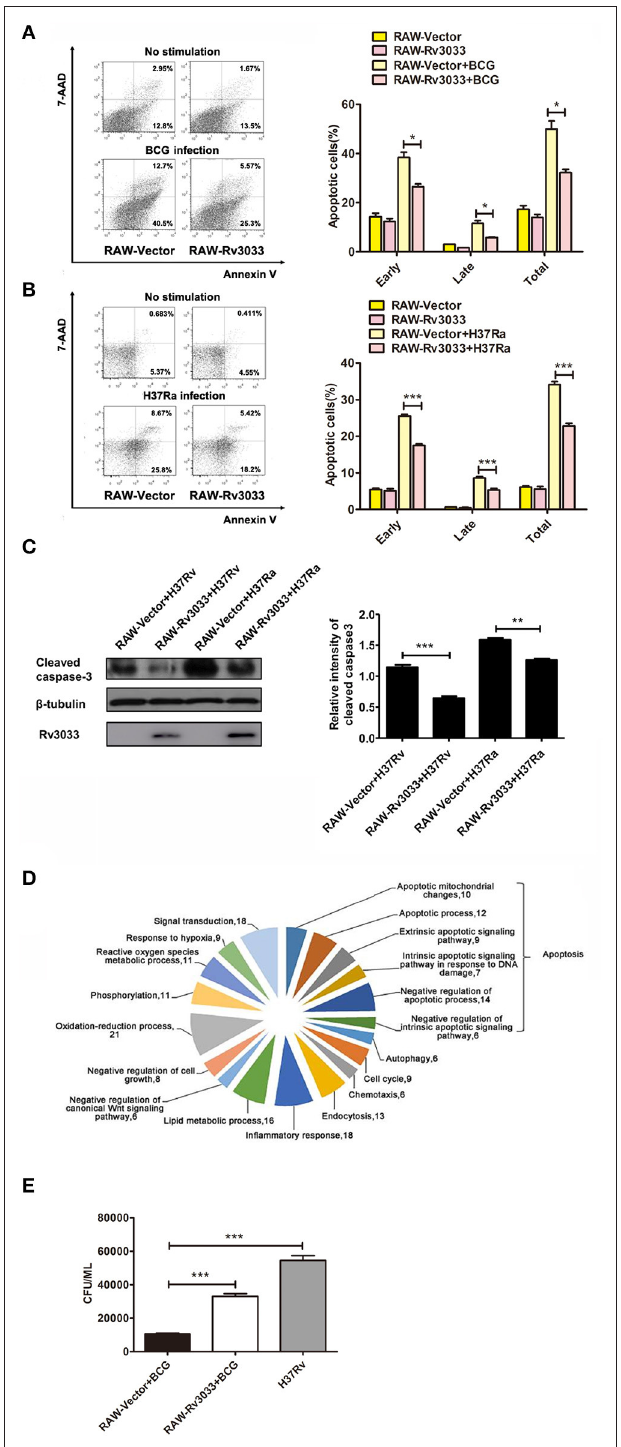
FIGURE 3 | Rv3033 decreased mycobacteria-induced macrophage apoptosis and promoted bacillary survival. (A) RAW-Vector and RAW-Rv3033 cells were infected with BCG (MOI = 10) for 36h. Apoptotic cells were determined by Annexin V/7-AAD staining assays. The percentages of early, late, and total apoptotic cells in FACS assay. (B) RAW-Vector and RAW-Rv3033 cells were